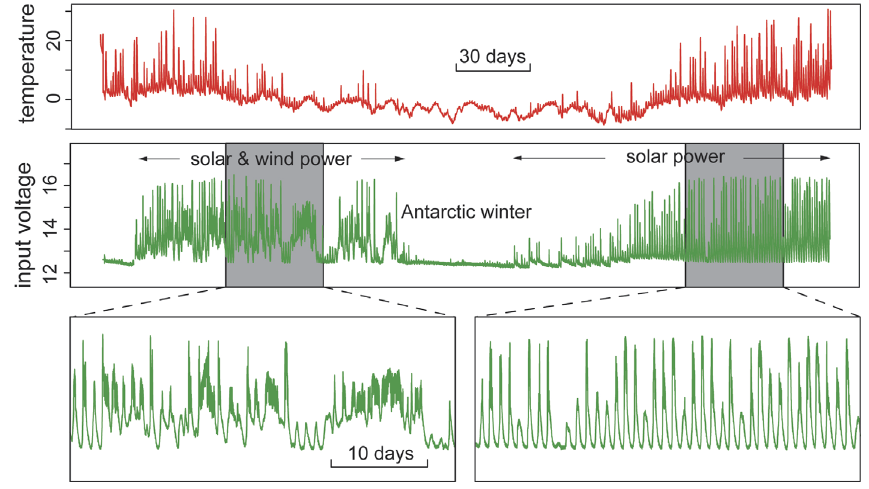
Figure 13. Evolution of system temperature (top, in red) and voltage (middle and bottom, in green) at the seismic station DCP during the year 2008. Zoomed windows (bottom) show the energy supply during periods with inputs from the solar panel and wind generators (bottom left) and from the solar panel only, after the wind generators were smashed during the Antarctic winter (bottom